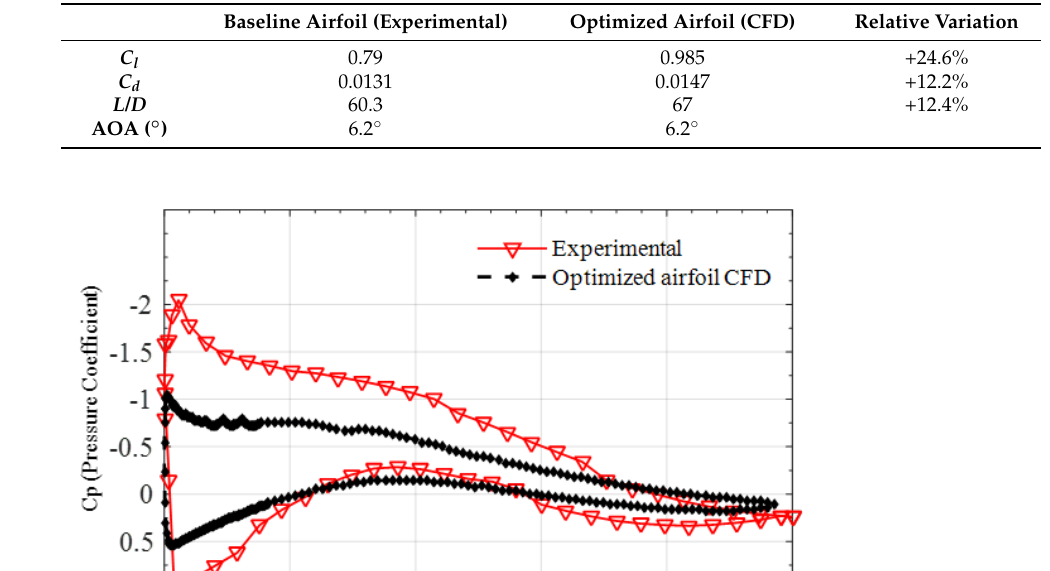
Table 7. Comparison of simulation data of the original and optimized airfoils by CFD (NREL S809).